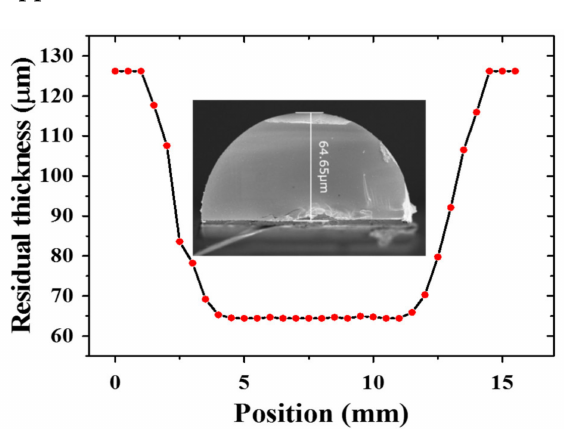
Figure A1. The residual thickness of the SPF. The uniform region of the SPF is about 8 mm thick, with two transition regions 3 mm in length. The inset shows the SEM image of the cross-section, indicating that the residual thickness of the uniform region is 64.65 µ m. Thus, part of the fiber core (1.85 µ m) is polished.